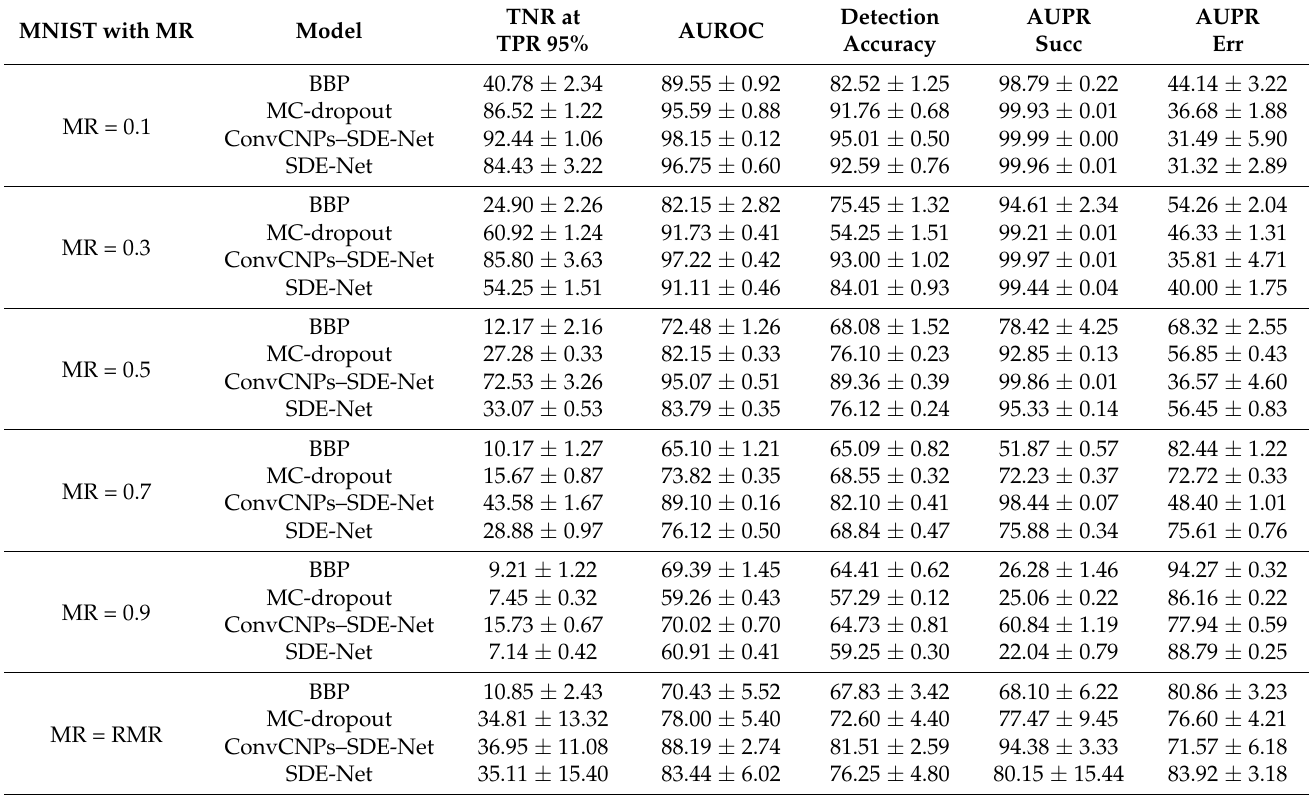
Table 4. Misclassification detection performance of the BBP, MC-dropout, ConvCNPs–SDE, and SDE-Net models on MNIST with MR = [0.1, 0.3, 0.5, 0.7, 0.9, RMR] and